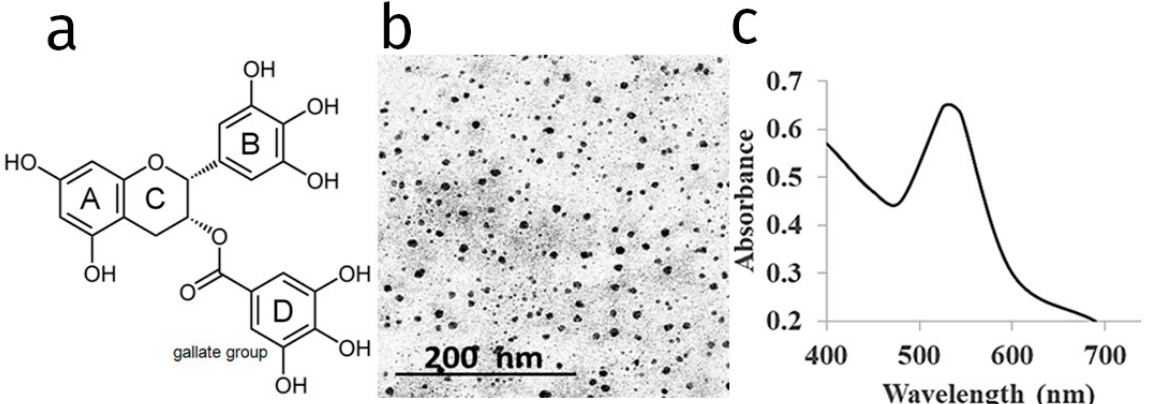
Figure 1. a. The chemical formula of epigallocatechin gallate (EGCG), illustrating the A-, B-, C- and D- rings. Characterization of EGCG-AuNPs: b. TEM image of EGCG-AuNPs and c. UV-visible spectrum of the prepared EGCG- AuNPs, with a λ at 535 max